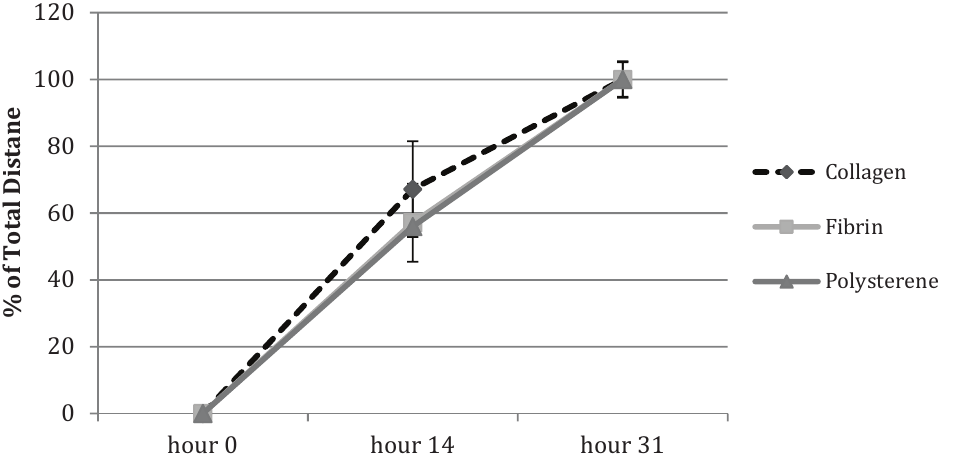
Figure 3 . Two-dimensional scratch wound assay. Percent of total distance migrated. Distance migrated measured in ImageJ as the distance between the two leading edges subtracted from the total distance at hour